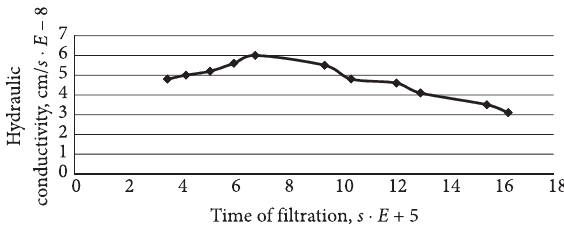
Fig. 2. Hydraulic conductivity of clay versus the filtering duration during the first filtering term